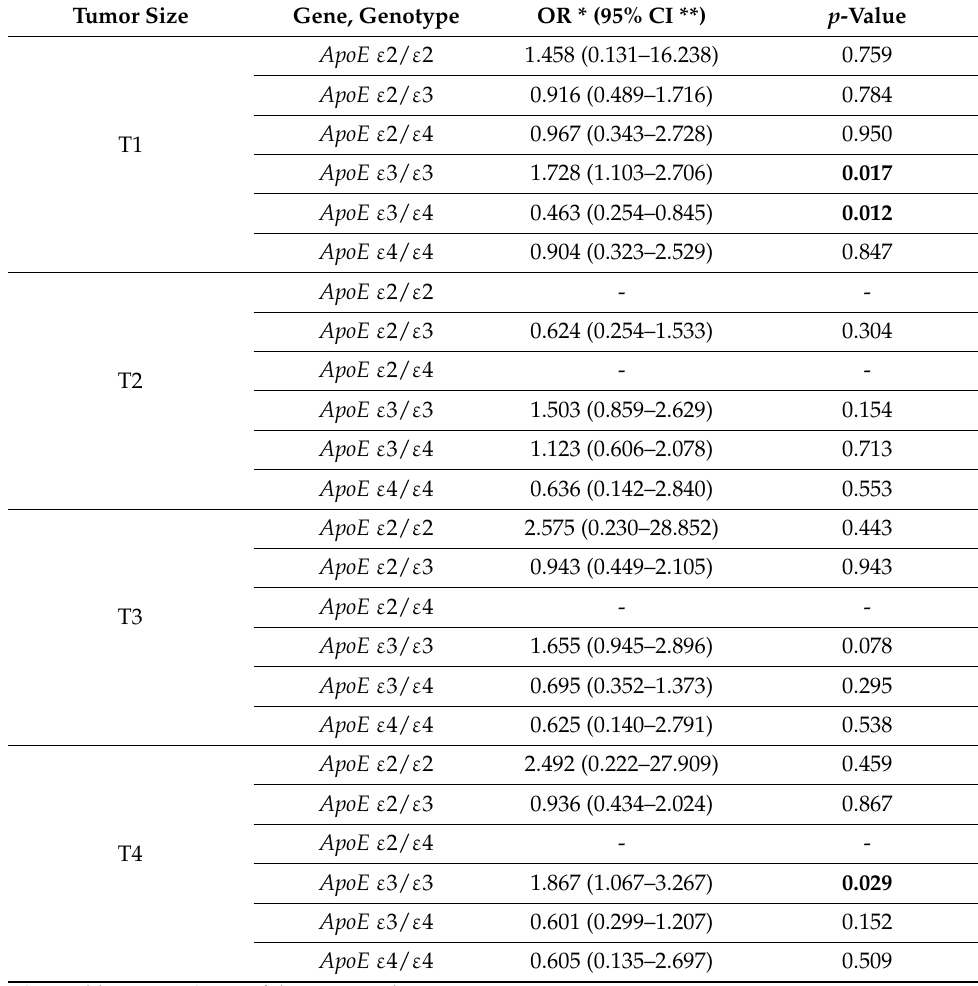
Table 7. Binary logistic regression analysis of ApoE in the control group and patients with LSCC in different tumor size subgroups.